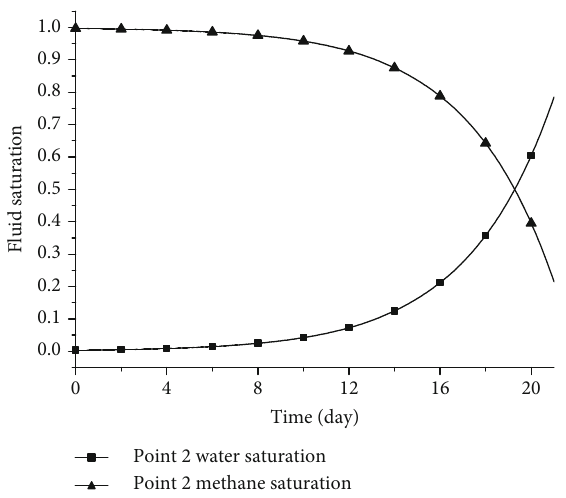
Figure 8: The permeability in the coal matrix.